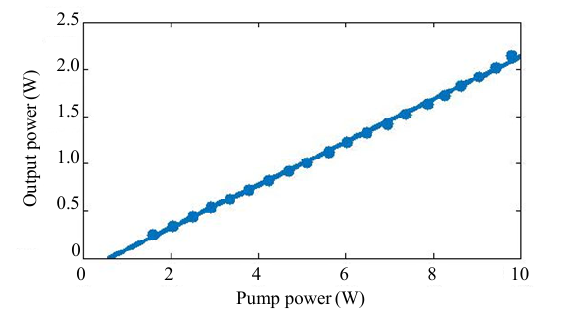
Fig. 4 Output lasing power versus LD pump power.